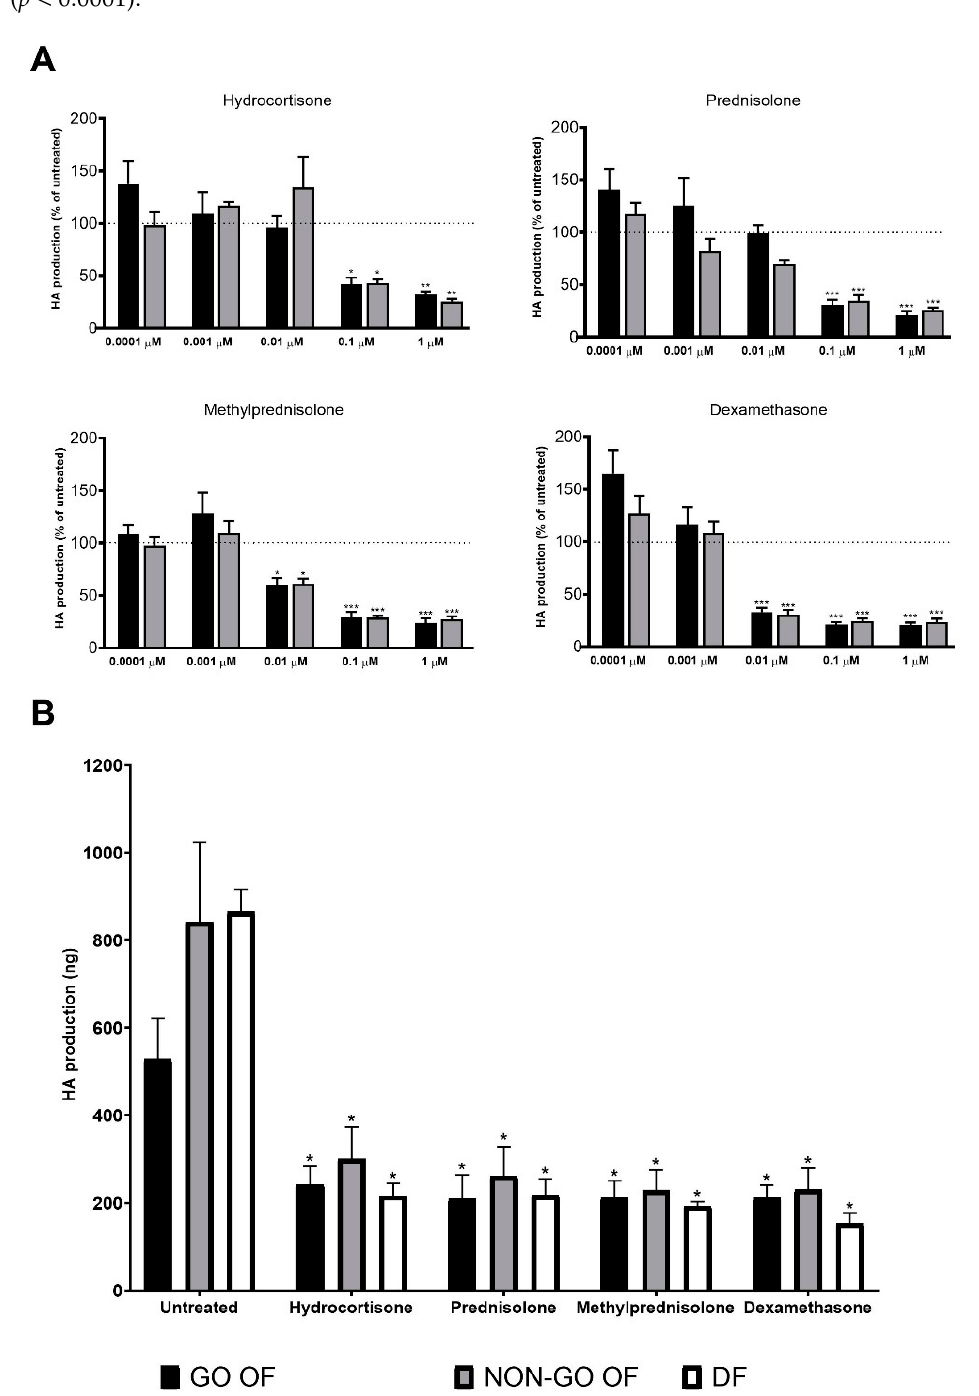
Figure 1. ( A ) The dose-dependent effect of 0.0001–1.0 µ M GCs on hyaluronan (HA) production, compared to untreated cells * p < 0.01, ** p < 0.001, *** p < 0.0001. ( B ) The influence of GCs (1 μ M) on HA production compared to untreated cultures. Data were analyzed using a repeated measures ANOVA followed by Dunnett’s test. Results shown are the mean ± SEM. * p < 0.0001. HA—hyaluronan, GO OF—Graves’ orbitopathy fibroblasts, NON ‐ GO OF—control orbital fibro ‐ blasts, DF—dermal fibroblasts .